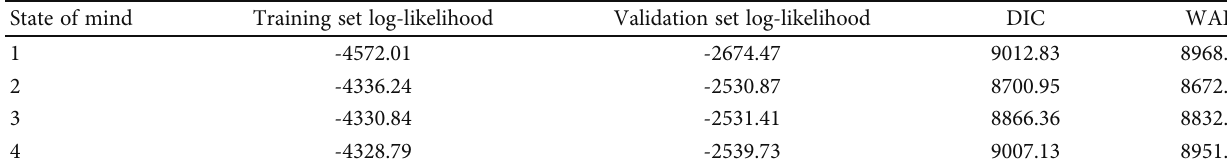
Table 3: Analysis results of state of